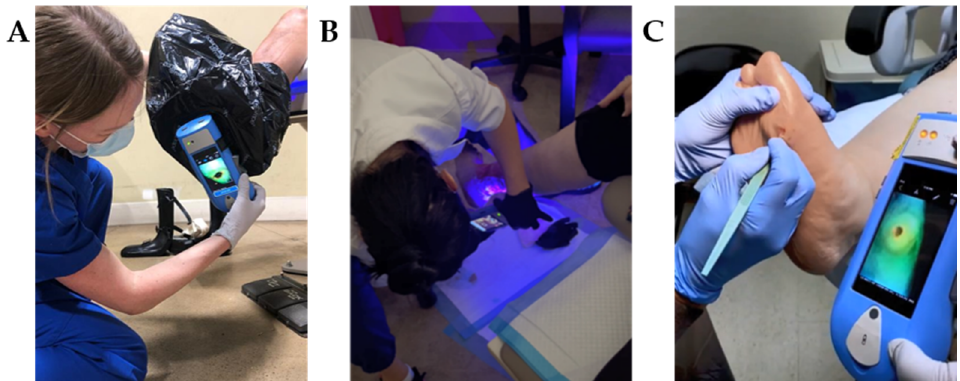
Figure 1. Fluorescence imaging procedure for wound bacterial presence, location and load performed across multiple sites of service. ( A ) When in a bright environment, a DarkDrape ® is attached and used to create adequate darkness. The drape is positioned around the anatomy and the fluorescence imaging device is positioned at an appropriate distance (8–12 cm) from the wound prior to focusing and capturing an image. ( B ) The DarkDrape ® is not required in a darkened environment. For large wounds wrapping around the anatomy, as shown here, multiple fields of view will be imaged and interpreted. ( C ) Fluorescence images can be immediately interpreted at the point-of-care to inform treatment. Multiple images may be acquired per visit to assess efficacy of treatments performed. This panel shows the image informing a physician’s debridement.